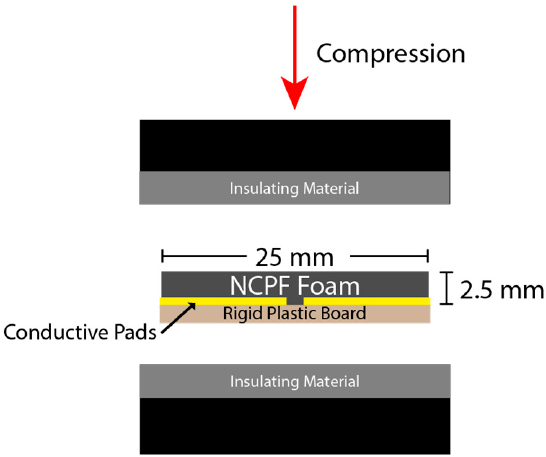
Figure 4. Schematic depicting experimental setup for in-plane sensor con fi guration to measure pie- zoresistive response to static loading. Direction of compression to induce static strain shown. The samples were compressed in the Instron to a maximum 0.7 strain to avoid foam densi fi cation, which occurs around 0.75–0.8 strain [26]. An oscilloscope and function gen- resistor in the instrumentation ampli fi er circuit as shown in Figure 5.